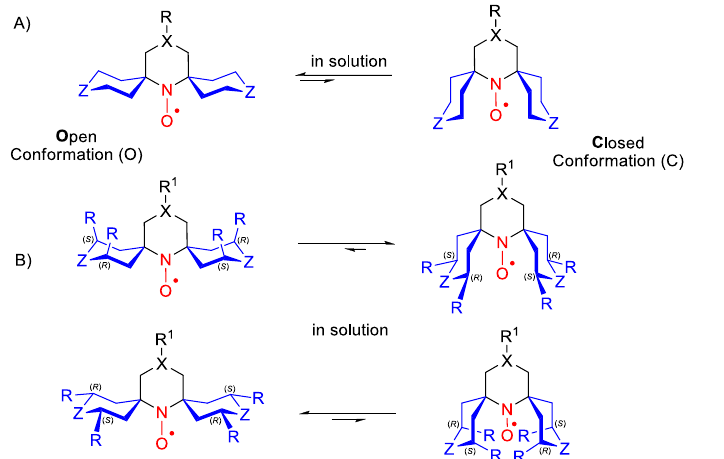
Figure 2. Equilibrium between open and closed conformations of TEMPO-like SNRs (A) in the absence of and (B) in the presence of substituents at the C-3,5 atoms of the spiroheterocycle (the ( R,S,R,S ) configuration is dominated by the closed conformation; the ( S,R,S,R ) configuration is dominated by the open conformation).